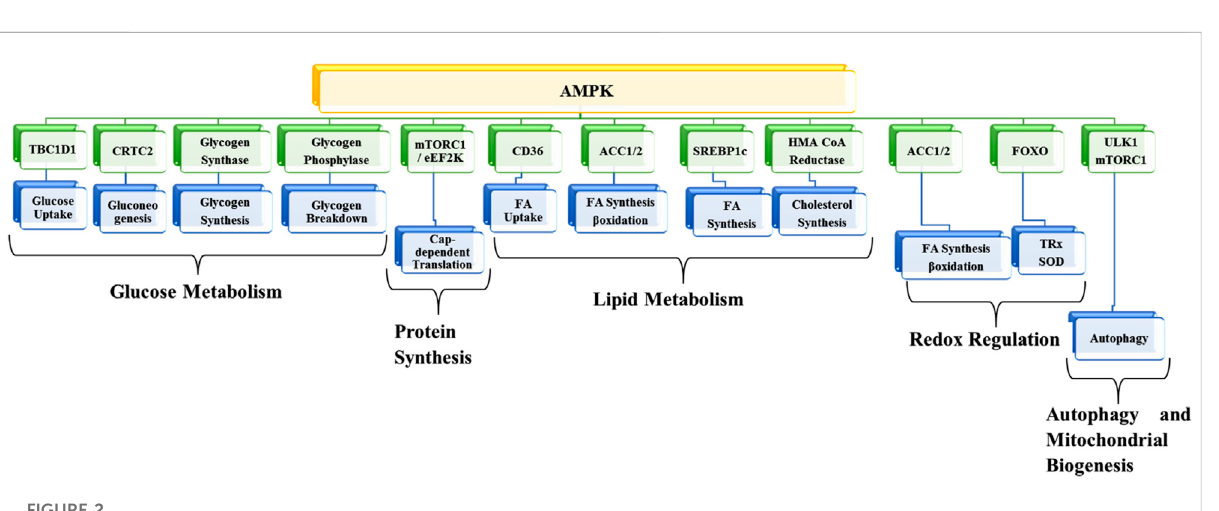
FIGURE 2 Metabolic functions of AMPK. TBC1D1, TBC1 domain family member 1; CRTC2, CREB-regulated transcription coactivator 2; mTORC1,